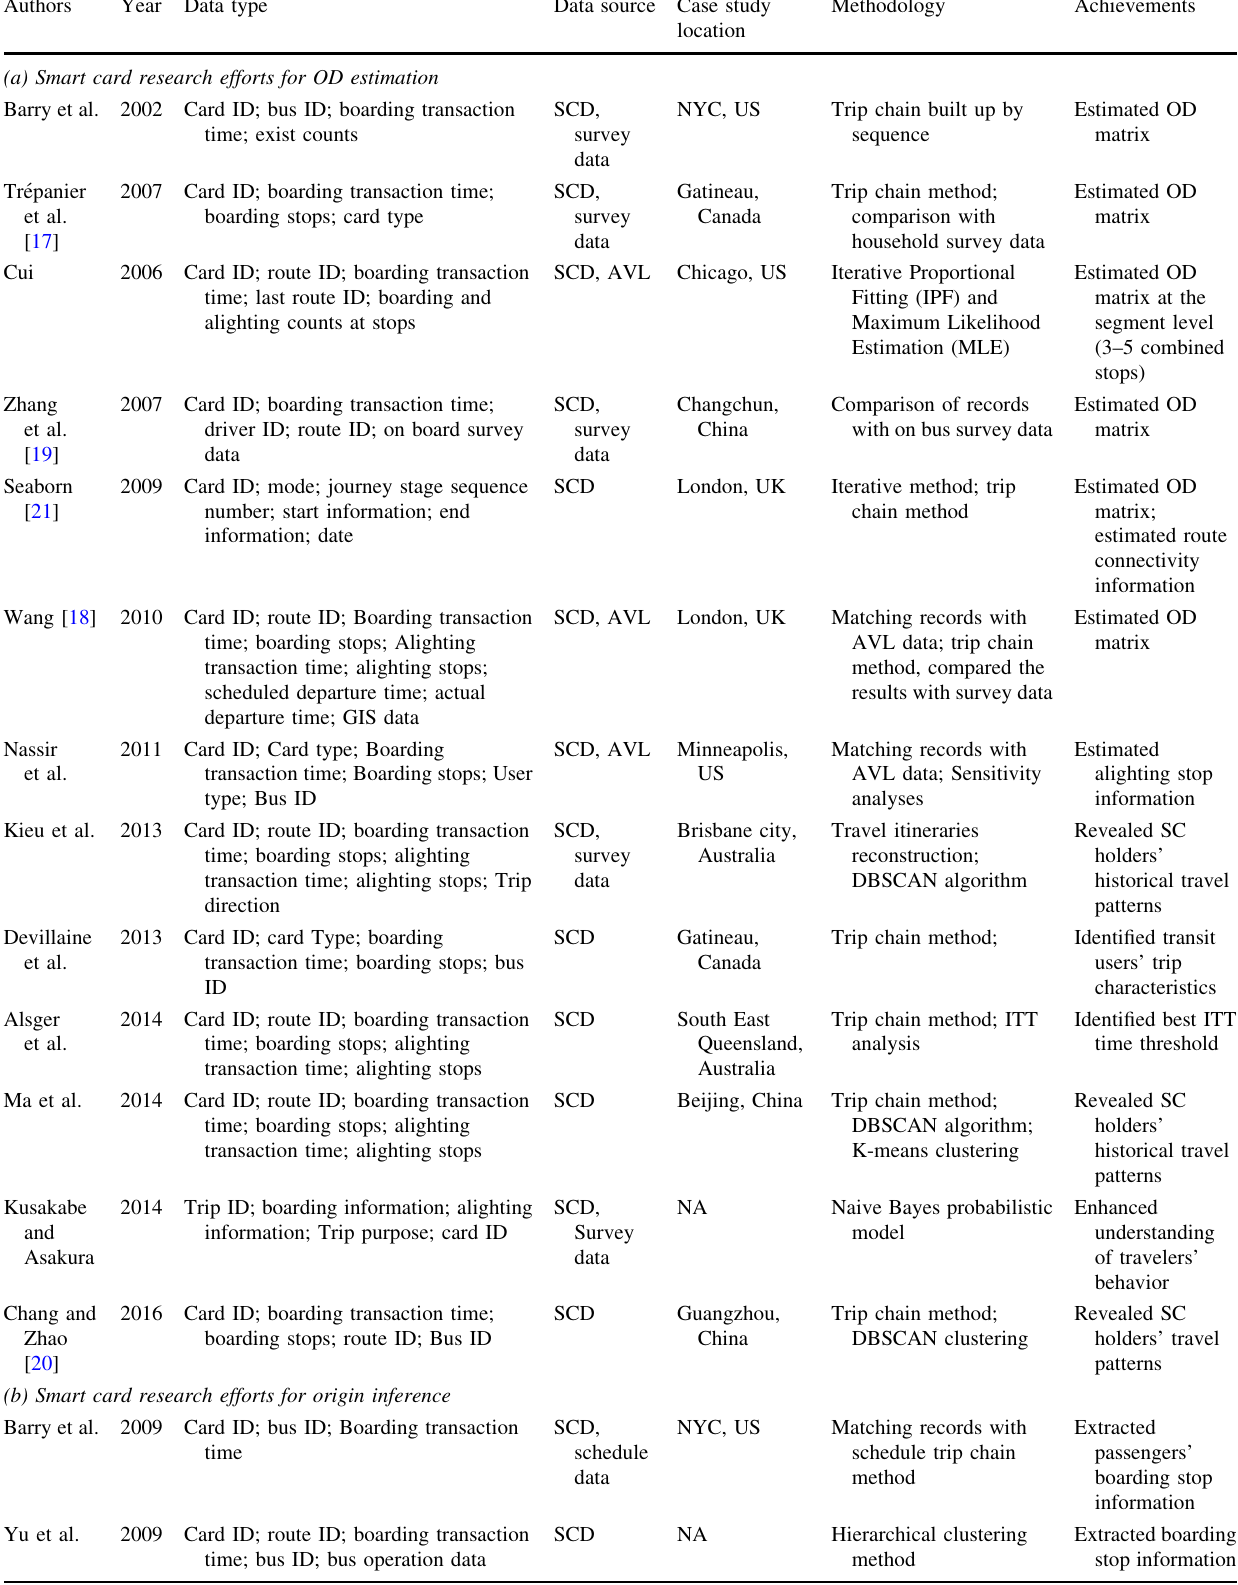
Table 1 Summary of existing smart card research efforts